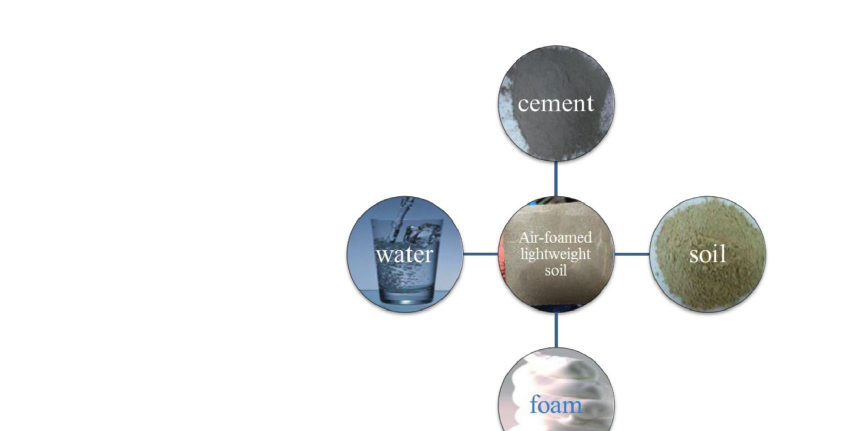
Figure 2: Research review outline.